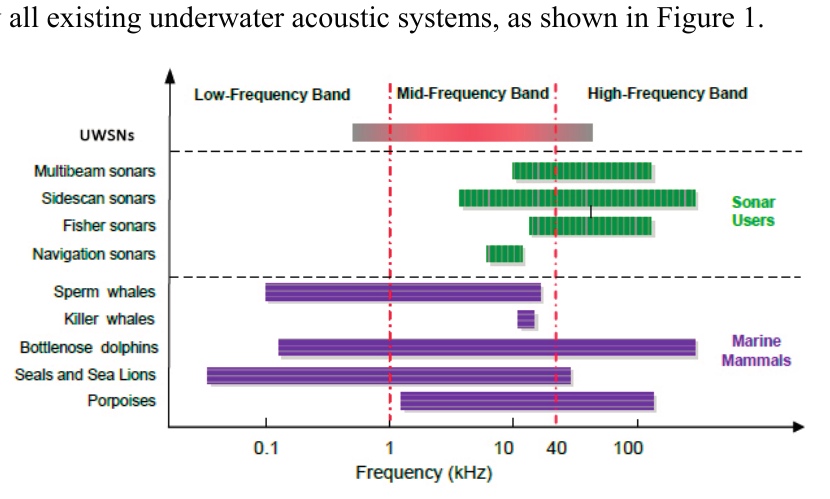
Figure 1. Spectrum share in underwater